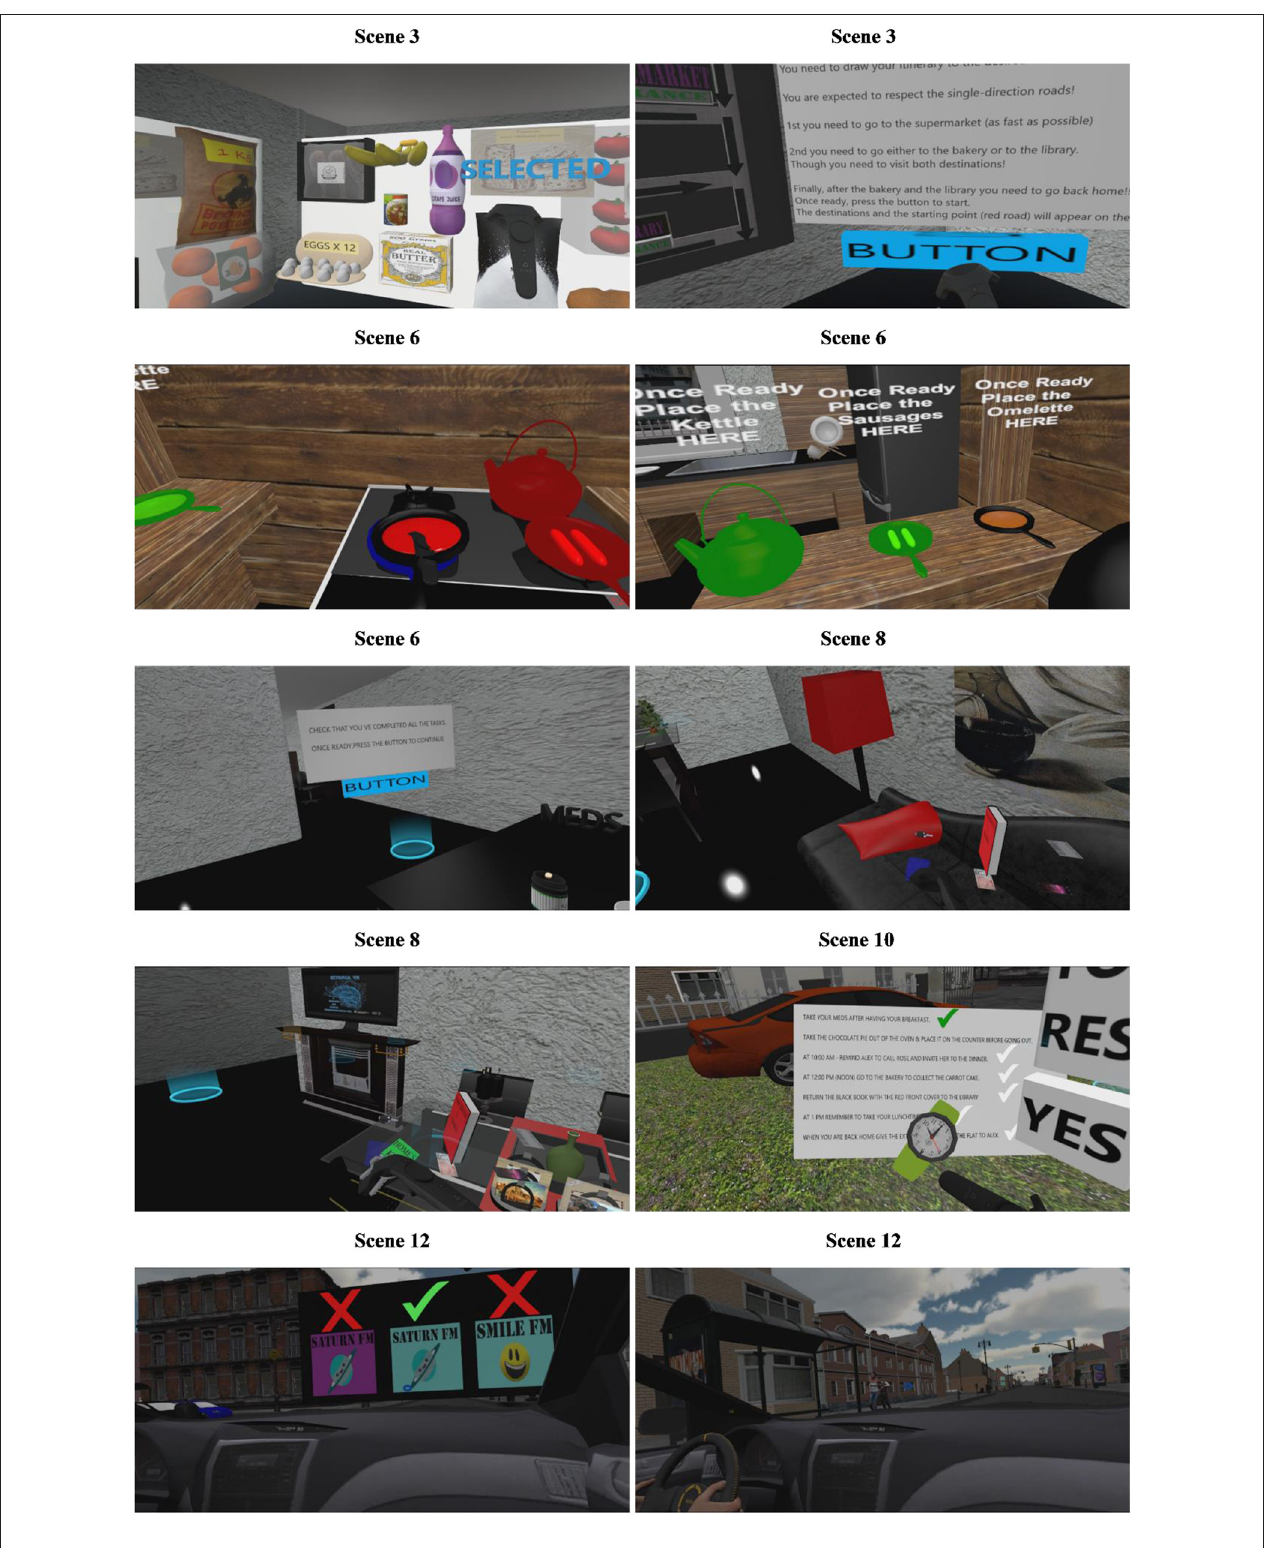
FIGURE 3 | VR-EAL storyline: scenes